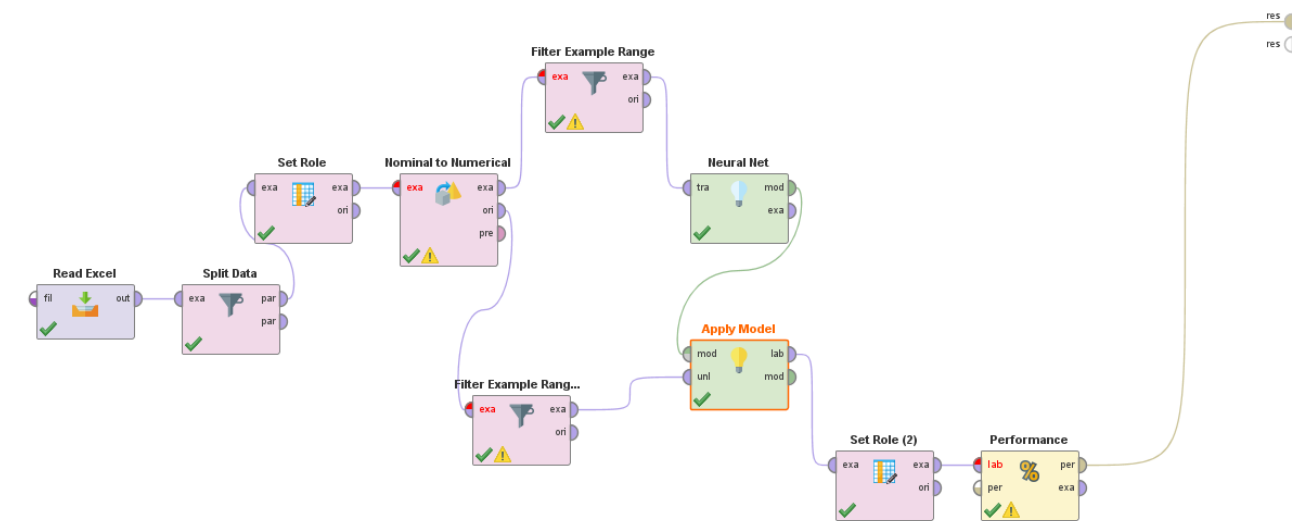
Figure A1. ANN MLP Rapid Miner workflow predicting outliers.